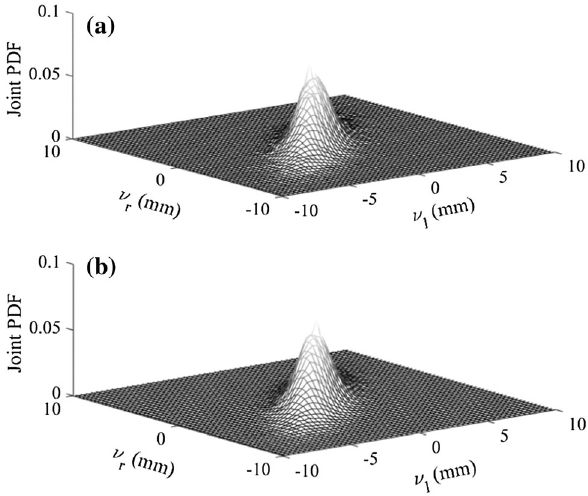
Fig. 6 Joint PDF comparison between vertical irregularities at left and right sides ( a simulation; b measurement)